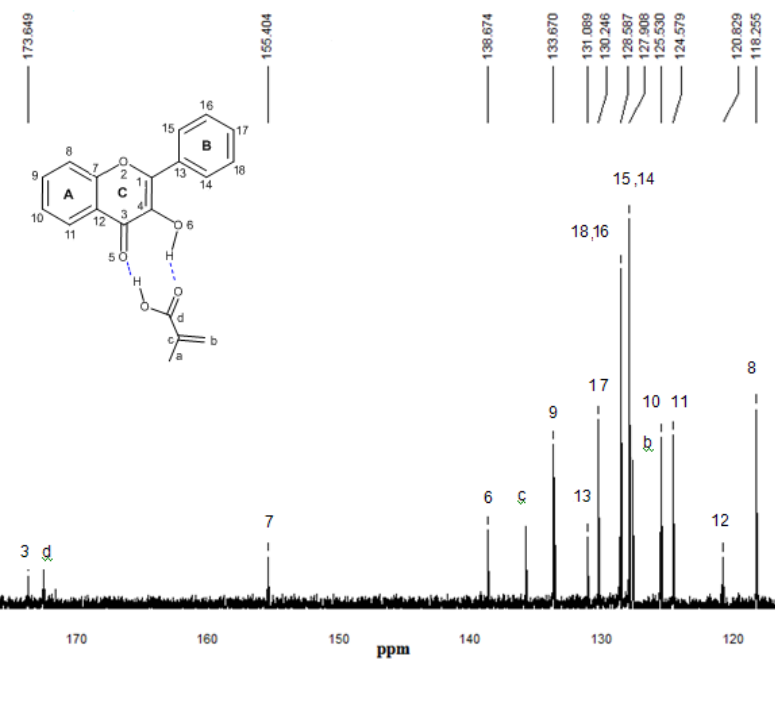
Figure 9. 13 C-NMR experimental spectrum of the complex FL-MAA 1:1 in CDCl numbering that appears on each signal is relative to carbon